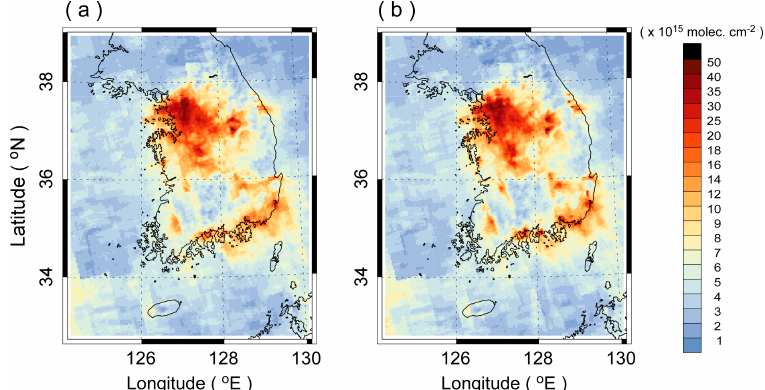
Figure 6. The spatial distributions of the fine-scale reconstructed OMI NO 2 VCD over the South Korean region obtained by applying the spatial-weight kernels from (a) WRF-Chem and (b) WRF/CMAQ.